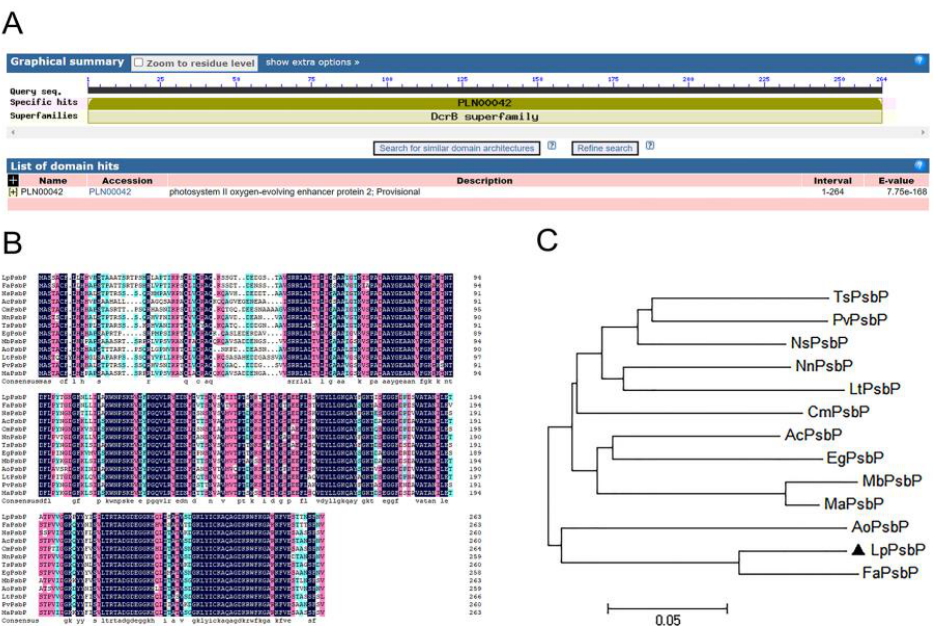
Figure 1. Bioinformatics analysis of LpPsbP. ( A ): Conservative domain analysis of LpPsbP using NCBI. Result shows that there is a highly conserved DcrB domain in LpPsbP. ( B ): Amino acid sequence alignment of LpPsbP with other homologous proteins of different plant species. The amino acid sequence of this transcript was similar to that alignment of the PsbP amino acid sequence from other species: Fritillaria agrestis , FaPsbP, O49080.1, 89.77%; Nyssa sinensis , NsPsbP, KAA8524123.1, 75.46%; Ananas comosus , AcPsbP, XP_020096384.1, 75.09%; Cinnamomum micranthum F. Kanehirae , CmPsbP, RWR81876.1, 73.98%; Nelumbo nucifera , NnPsbP, XP_010247826.1, 73.64%; Tetracentron sinense , TsPsbP, KAF8408713.1, 75.46%; Elaeis guineensis , EgPsbP, XP_010906959.1, 75.00%; Musa balbisiana , MbPsbP, THU61210.1, 77.53%; Asparagus officinalis , AoPsbP, XP_020256197.1, 73.23%; Ipomoea triloba , LtPsbP, XP_031126809.1, 75.75%; Pistacia vera , PvPsbP, XP_031257256.1, 73.23%; Musa acuminata , MaPsbP, XP_009407699.1, 76.78%. ( C ): Phylogenetic tree analysis of LpPsbP and its homologous proteins. The scale bar represents that there is a 5% difference in this given length. The related species are shown in ( B